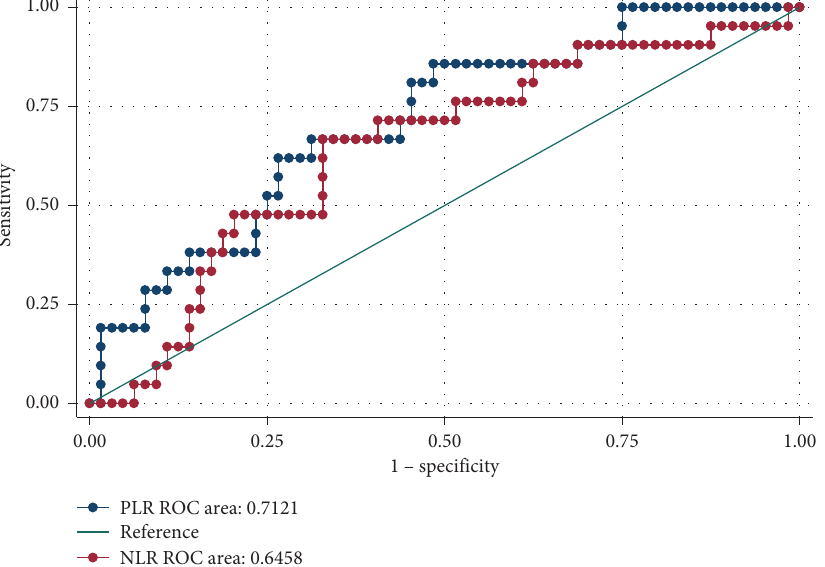
Figure 3: Analysis of the ROC curve for different cutoff points for NLR and PLR in patients with nondialysis chronic kidney disease using the ROC curve and area under curve (AUC) test. ROC: receiver operating characteristic; NLR: neutrophil-to-lymphocyte ratio; and PLR: platelet-to-lymphocyte